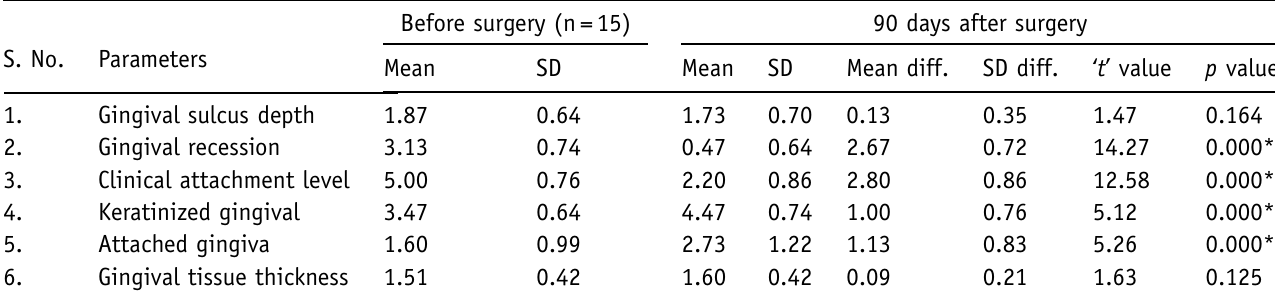
Table III. Shows the evaluation of parameters for recipient teeth before and 90 days after surgery in test group (CAF + Hyaloss).